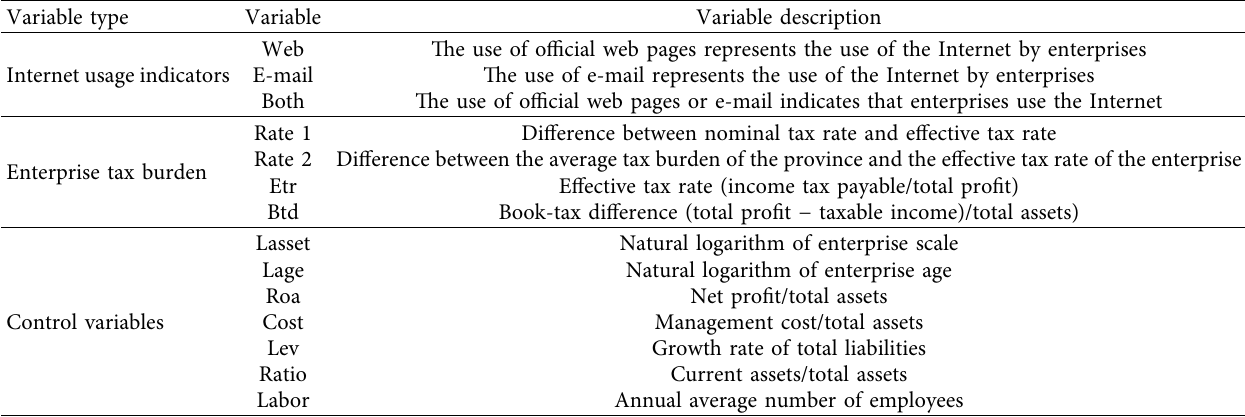
Table 1: Variable measurement.